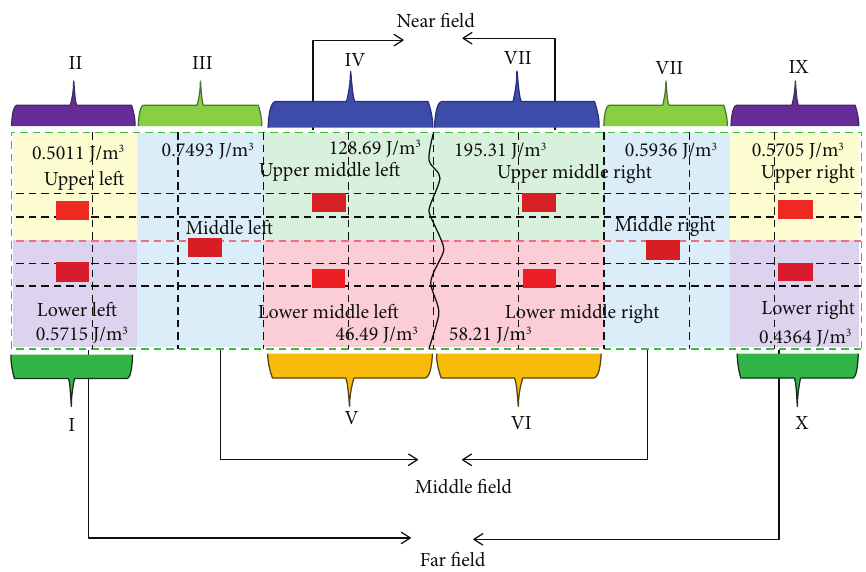
Figure 12: Elastic strain energy density at feature